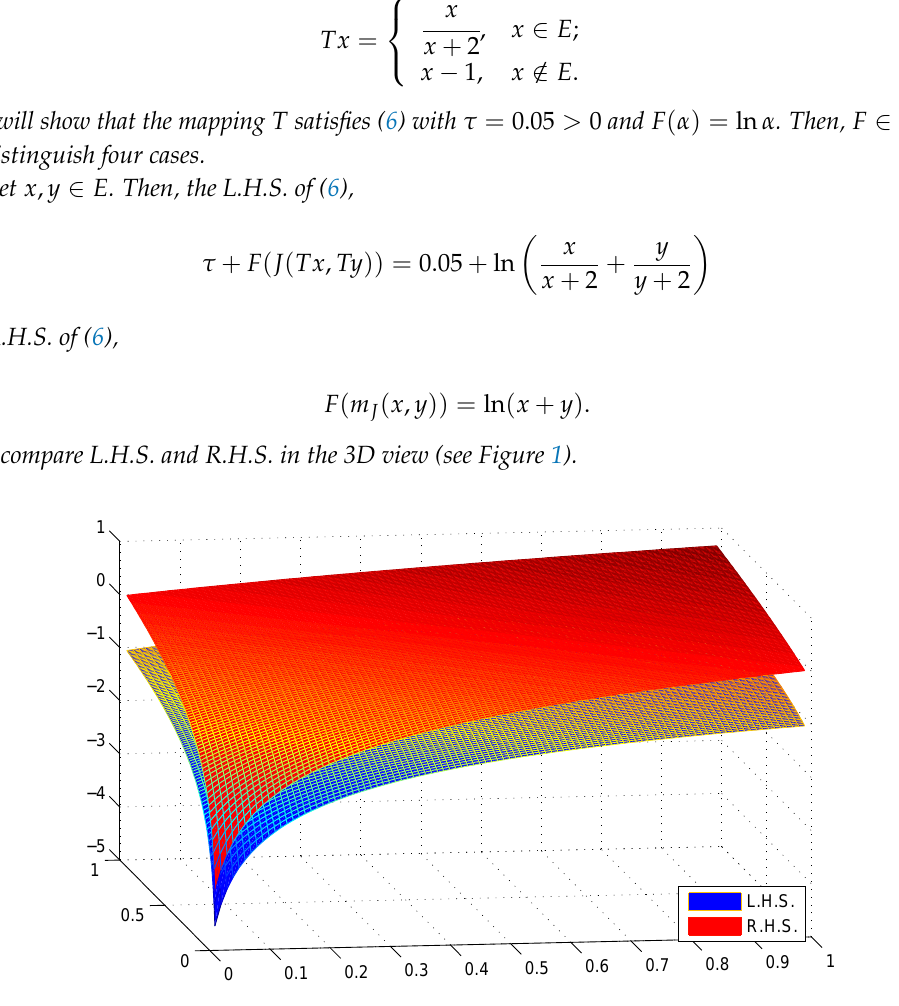
Figure 1. The value of comparison of the L.H.S. and R.H.S. of Equation (6) in the 3D